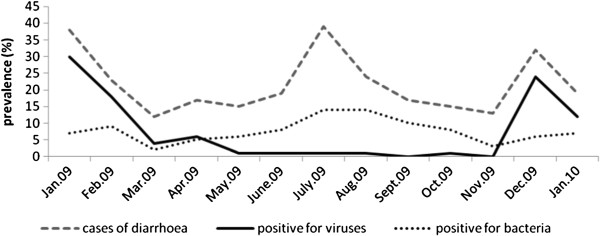
Seasonality of the acute diarrhea and the detection frequency of enteropathogenic bacteria and viruses in the stool samples of 283 children suffering from gastroenteritis in Ouagadougou, Burkina Faso.